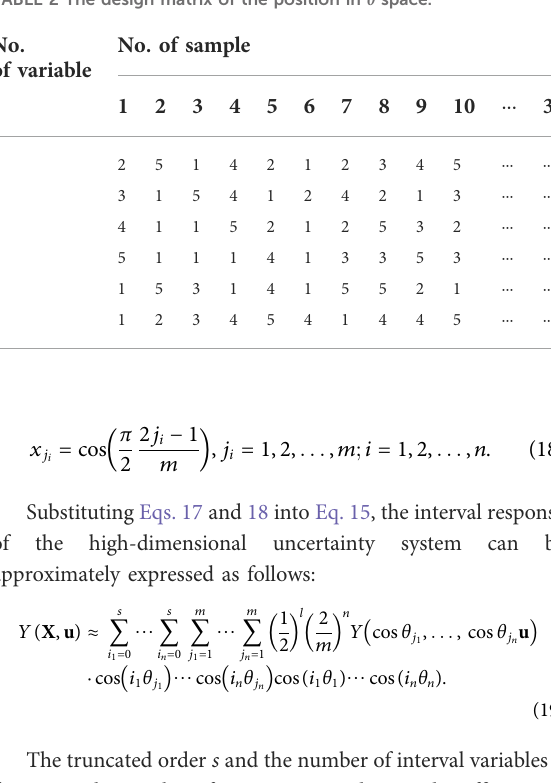
TABLE 1 First m samples in θ space. TABLE 2 The design matrix of the position in θ